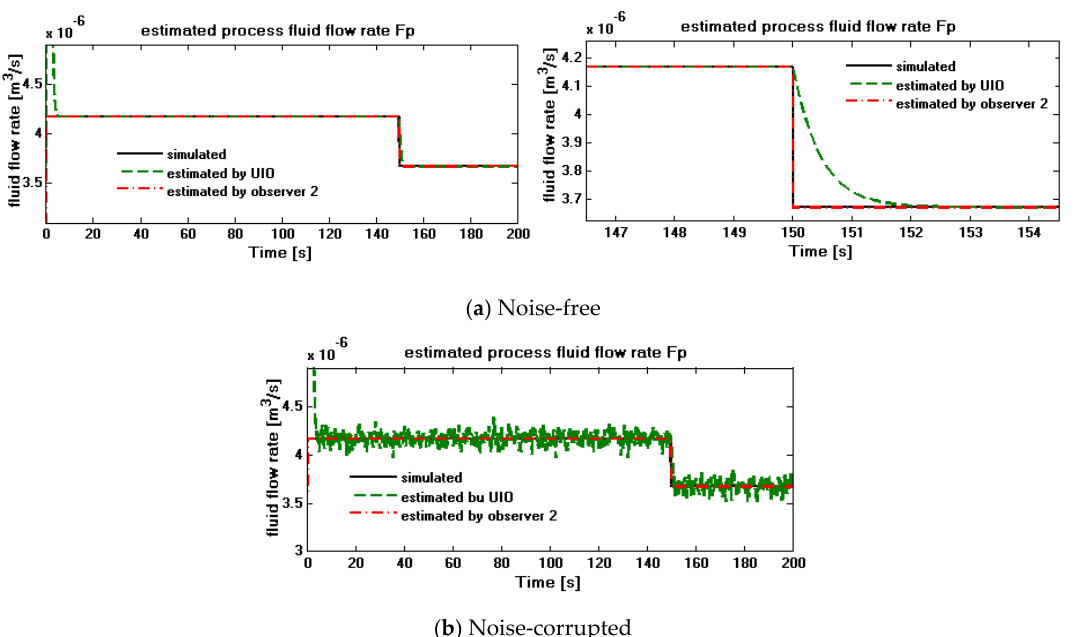
Figure 9. The computation and estimation of the process fluid flow rate F p . The solid line is the computed value; the dashed line is estimated by the UIO; and the dashed, dotted line is estimated by Observer 2. ( a ) represents Noise-free case while ( b ) represents Noise-corrupted case.